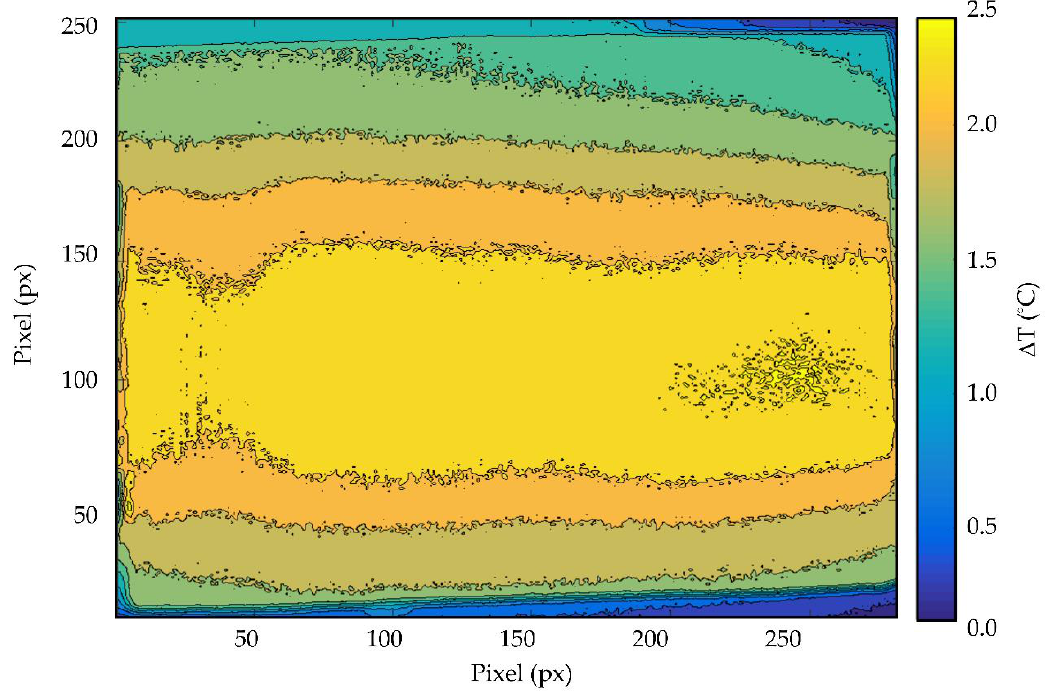
Figure 7. Illustration of distribution of temperature increases observed in the investigated prototype sample after 60,000 cycles of charging / discharging at a current density of 5 A / g and polarizing voltage 1.5 V; no serious changes of C and R ESR were recorded.